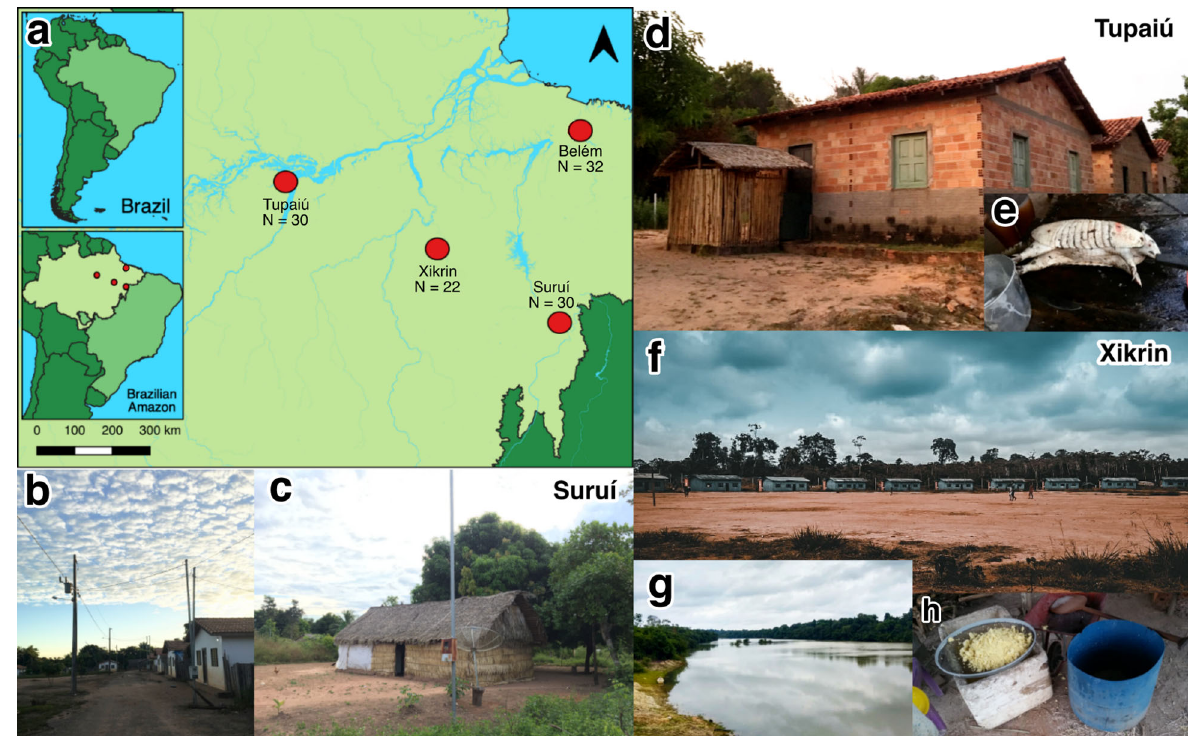
Fig. 1 Map and lifestyle patterns of the sampled populations. a Location of each sampling site in relation to the South American continent and the Brazilian Amazon. b , c The village and typical Suruí (R) residence. d , e Tupaiú (R) home and armadillo being prepared for consumption. f – h A circular arrangement of Xikrin (R) households, the nearby Bacajá River and the preparation of the cassava fl